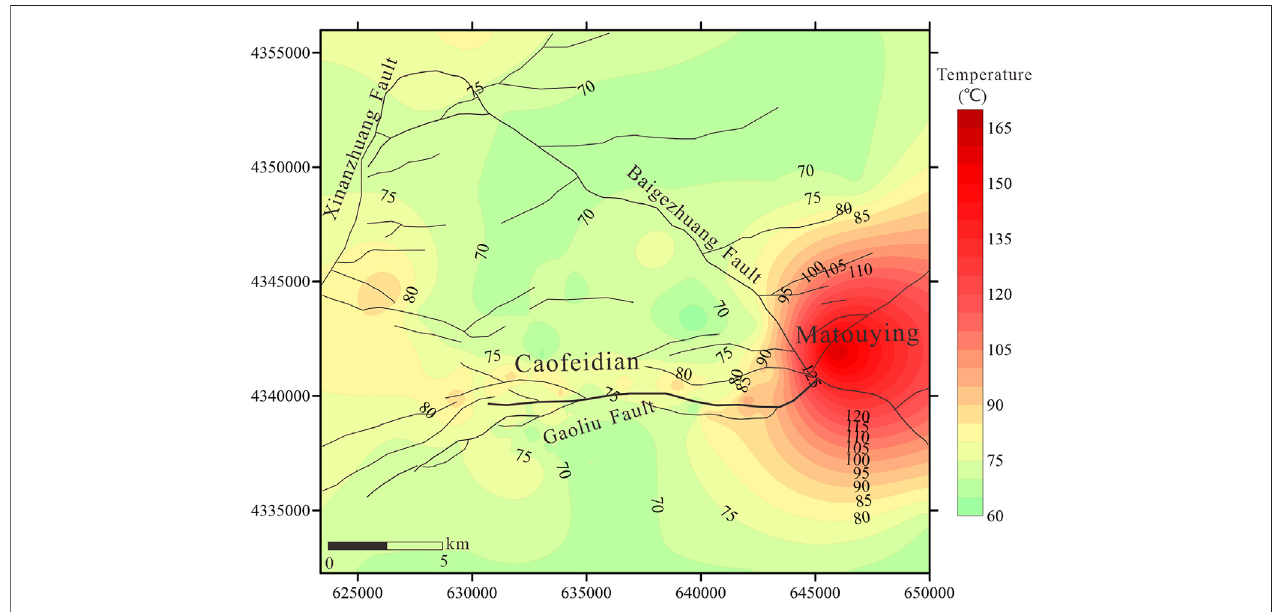
FIGURE 4 | Temperature gradient of the geothermal wells at the depth of 2120m in the study area.